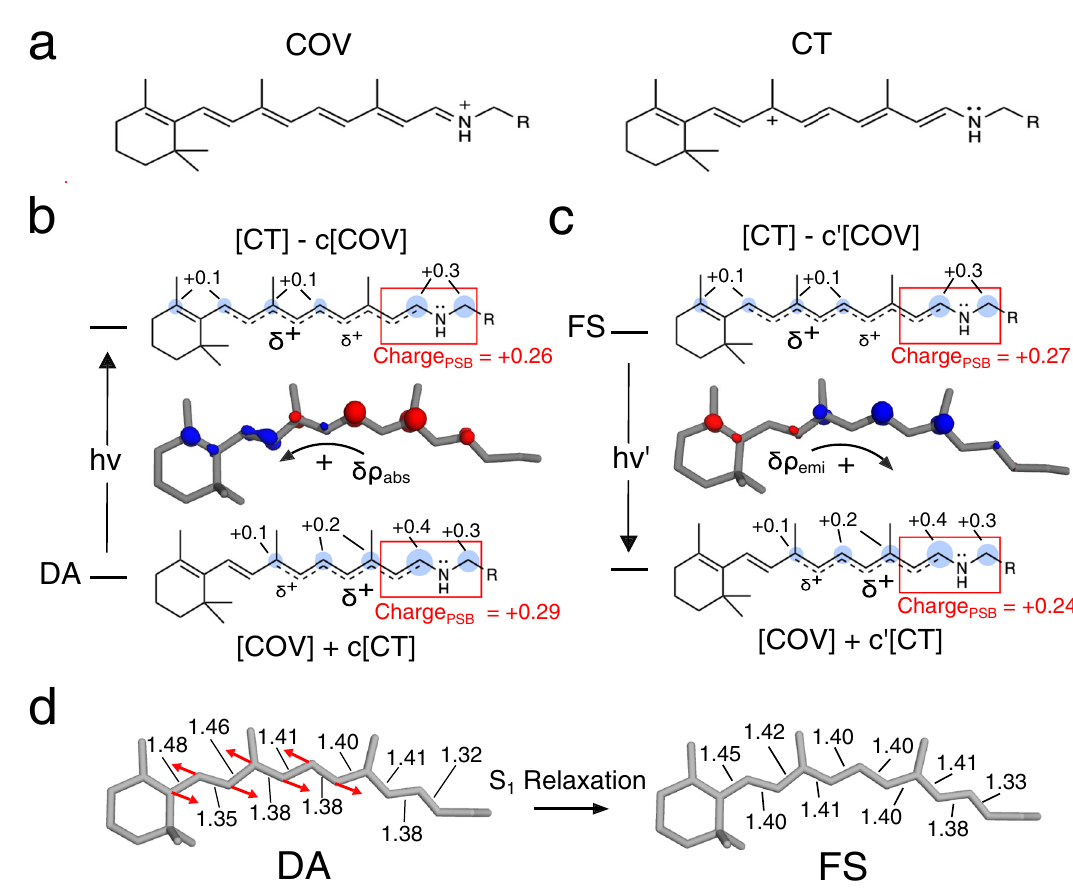
Fig. 3 | Electronic and geometrical character of S 1 relaxation in NeoR chro- mophore. a Representation of the two limiting resonance formulas adopted to describe the electronic character of the rPSB chromophore. b Electron density variation( δρ abs )characterizingtheverticalS 0 → S 1 transitionfromtheDarkAdapted State (DA). Blue and red clouds correspond to electron density decrease and increaserespectively.Isovaluesetto0.002a.u.Theassociatedresonanceformulas correspondtoresonancehybridsalsoanticipatedinFig.1a.Bluebubblesrepresent the QM positive charge (in eunites). Onlyabsolutevalues > 0.05e arereported.As